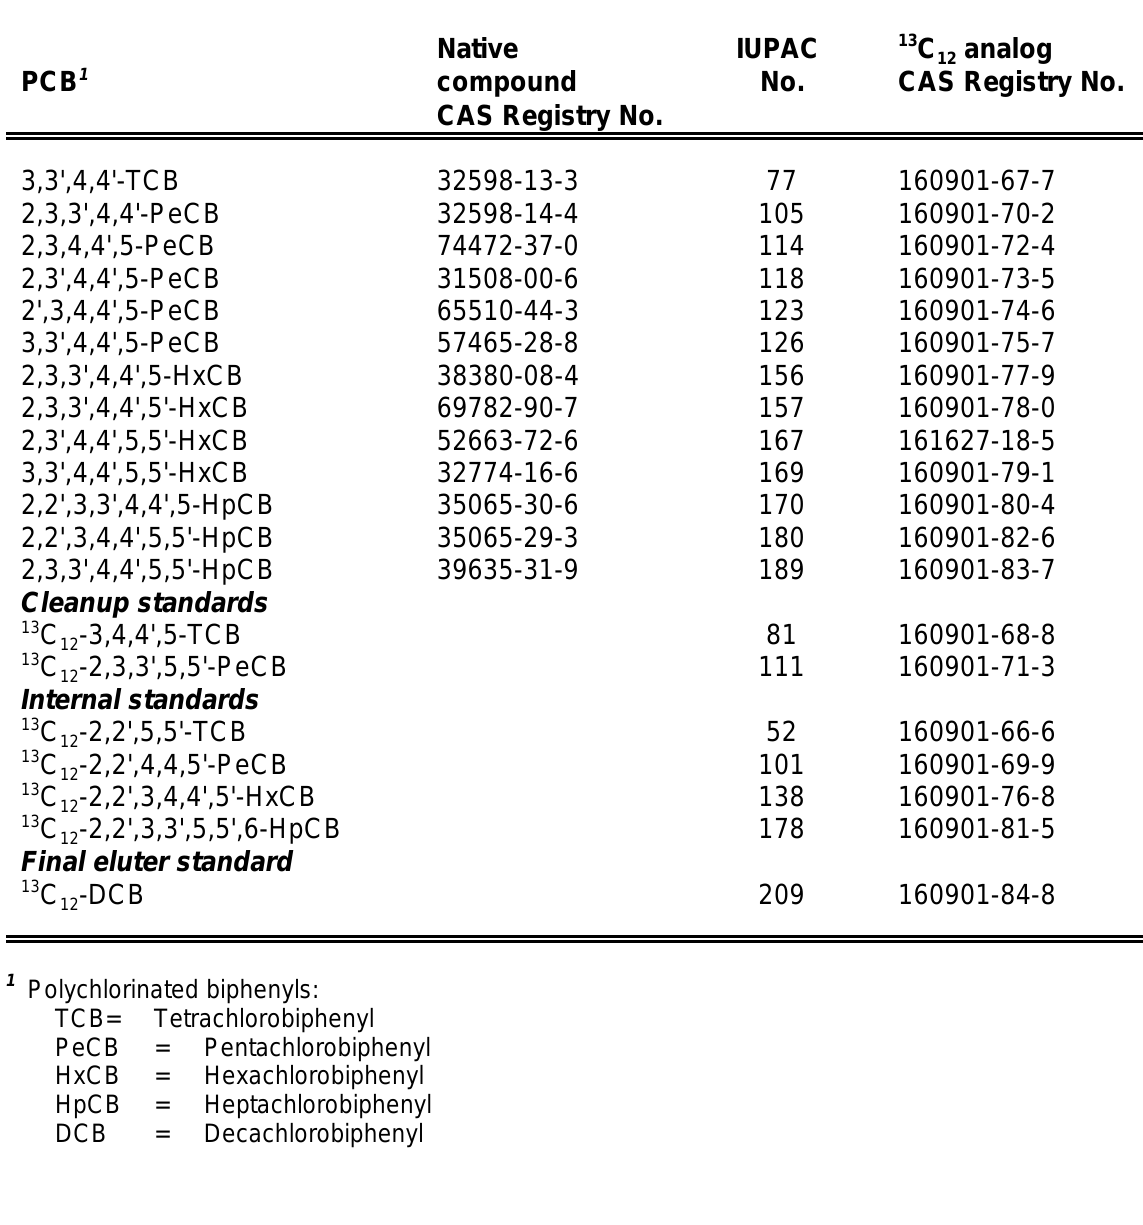
Table 1. Toxic Polychlorinated Biphenyls Determined by Isotope Dilution and Internal Standard High Resolution Gas Chromatography (HRGC)/High Resolution Mass Spectrometry (HRMS) PCB 1